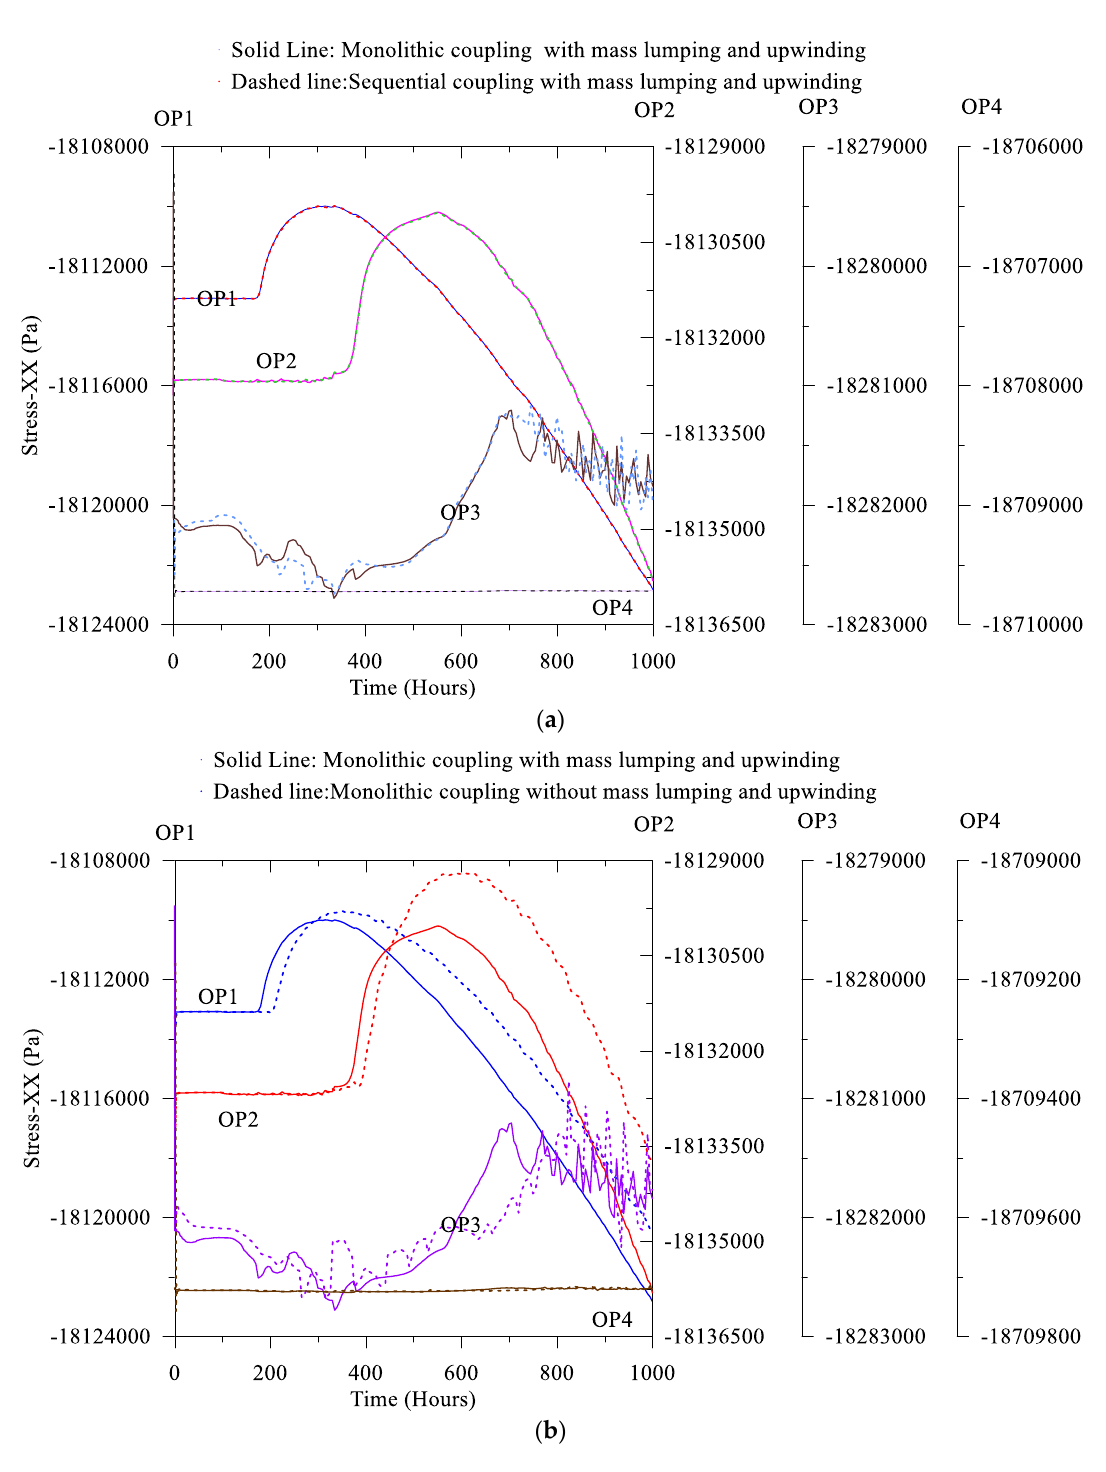
Figure 12. Comparisons of the stress along the X -axis: ( a ) the monolithic coupling and the sequential coupling and ( b ) with and without the mass lumping and the upwinding.